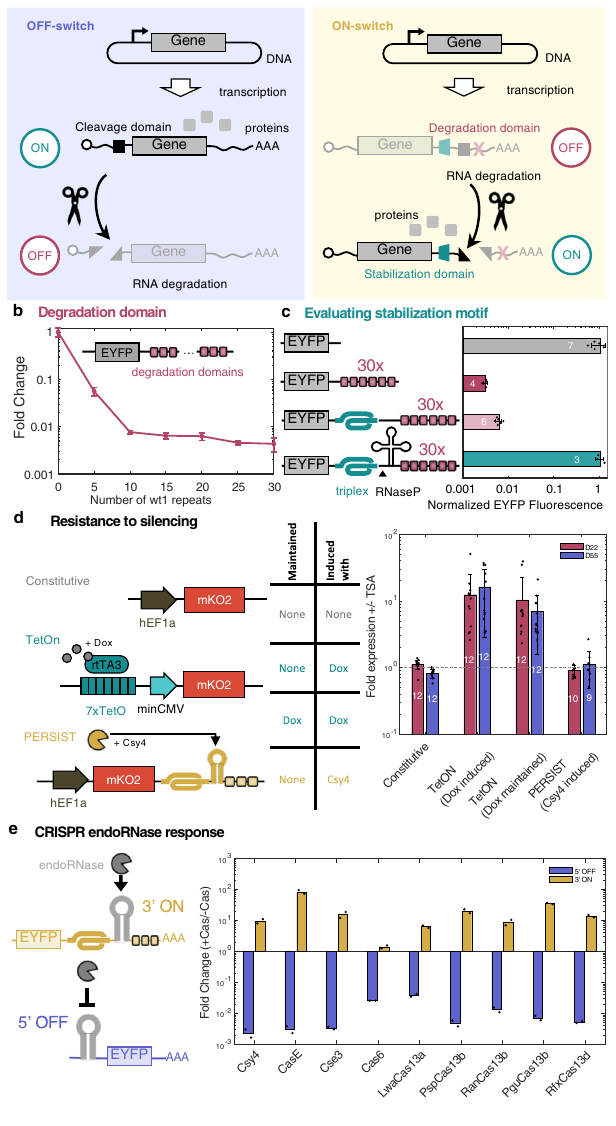
Fig. 1 Engineering PERSIST-OFF- and ON- motifs for regulated gene expression. a Schematic of RNA-based OFF-switch and ON-switch motif designs that are regulated by RNA cleavage. b Gene expression reduction due to appending increasing numbers of degradation motifs. Fold change was calculated as described in Supplementary Fig. 3. n = 3 biologically independent samples where each sample represents the evaluation of >1000 transfected cells (HEK293FT). Data are presented as mean ± s.d. c Triplex structure rescues gene expression only after removal of degradation motifs by RNase P. Data were analyzed from the total number of samples indicated in the bars where each sample represents the evaluation of >1000 transfected cells (HEK293FT). Data are presented as mean ± s.d. d PERSIST shows resistance to epigenetic silencing in clonal populations. Three different constructs (left) each expressing mKO2 (constitutive, Tet-On switch, or PERSIST-ON switch) were genomically integrated and single-cell sorted to evaluate clonal silencing effects (see Supplementary Fig. 5). The table (middle) shows the maintenance and induction conditions of each cell line. 22 and 55 days after sorting 12 clonal lines for each cell type were induced with either 4 μ M Dox or transfected with Csy4 both in the presence and absence of TSA and evaluated by fl ow cytometry two days later. The ratio of ±TSA for mKO2 expression was calculated for each cell line in each sample type where a ratio >1 indicates rescue of response by TSA. The Tet-On system shows increased mKO2